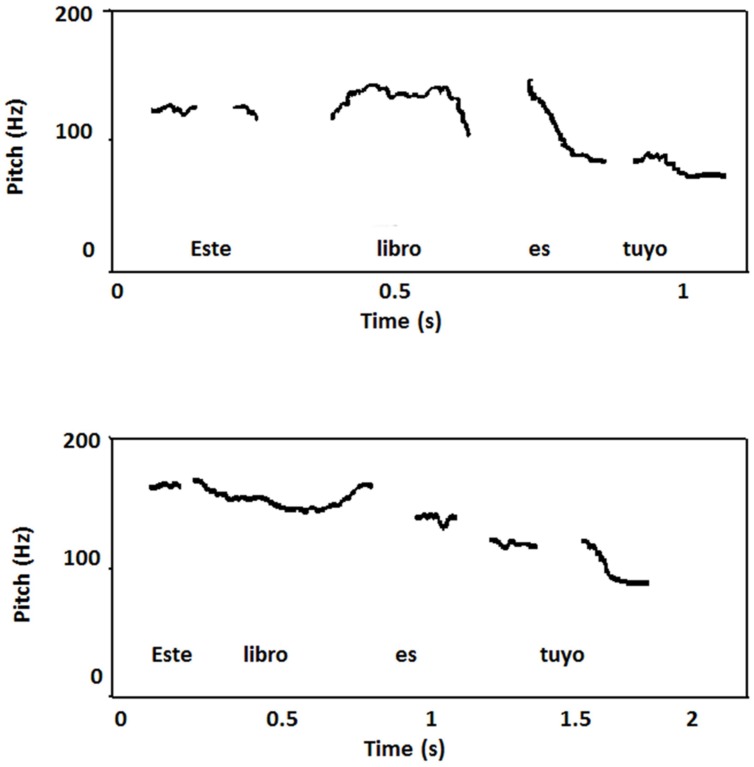
Plot of the Spanish sentence “Este libro es tuyo” (“This book is yours”) pronounced by patient RC (top) and one of the healthy controls with typical Buenos Aires’s accent (bottom). RC a slow speaking rate in part due to the insertion of inappropriate pauses. Curves showed less declining trend than healthy controls and in the in the last portion of the utterances F0 he continued to rise even in unaccented syllables.